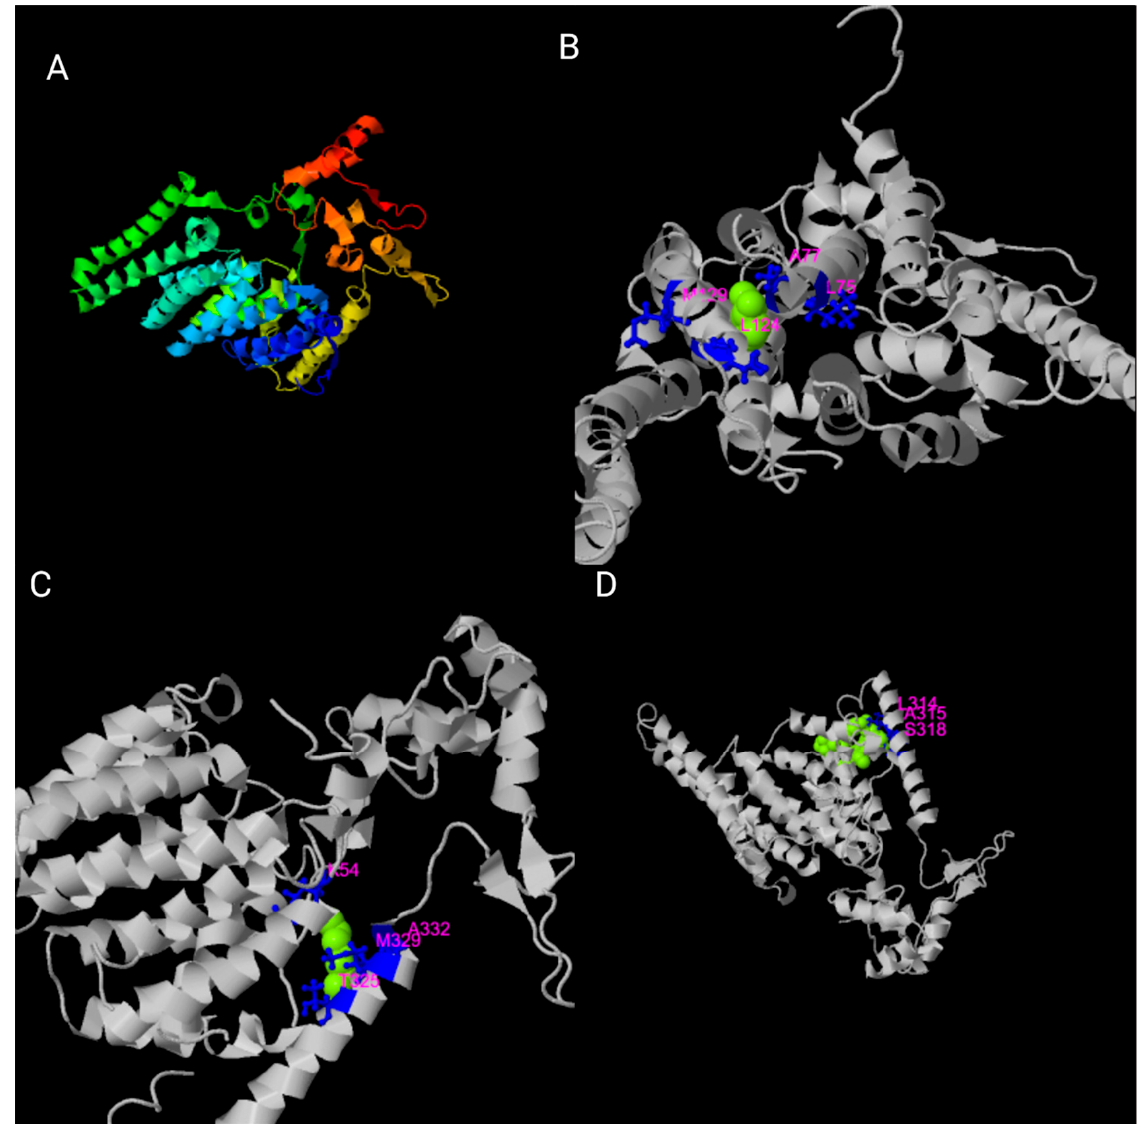
Figure 5. Predicted ligands for TMEM135 using I-TASSER software [71,72,107]. ( A ) The different colors represent the different alpha helixes. ( B – D ) I-TASSER (version 5.1) software provides biological annotations of the target ligand by COACH based on the I-TASSER structure prediction, represented by the magenta-colored amino acid residues. Figure created with BioRender.com (accessed on 15 June